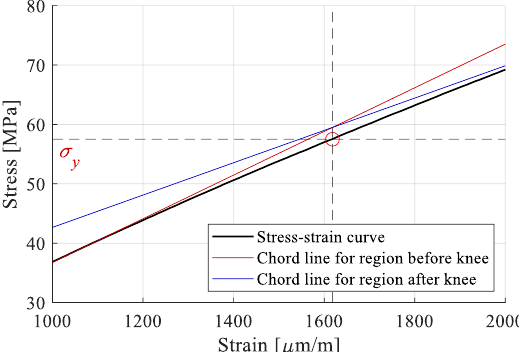
Figure 9. Detail on the calculus of σ y . Table 3. Calculated mechanical properties of the flax fiber — epoxy resin composite.